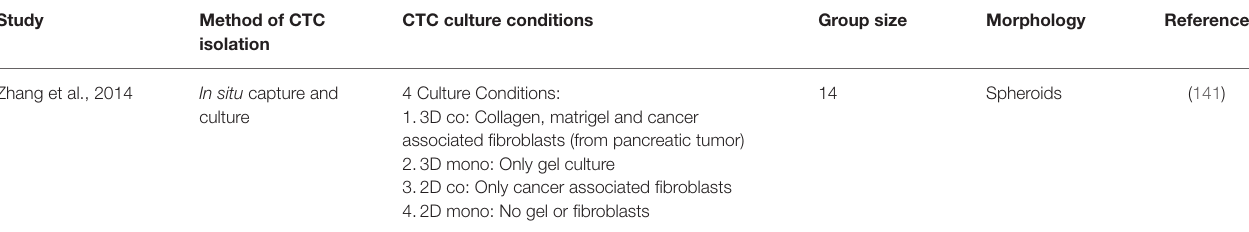
TABLE 4 | Summary of short-term Circulating Tumor Cell culture in Lung